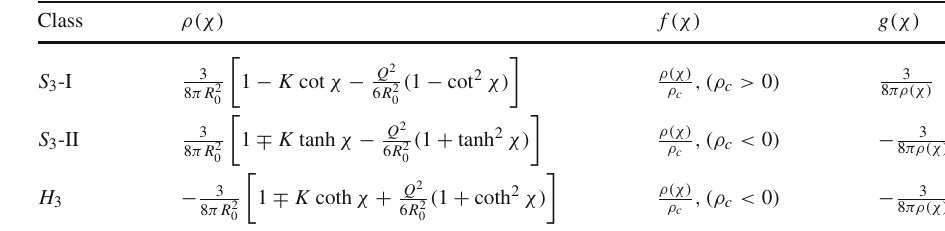
solutions. The signature of ρ c is chosen so that f (χ) g (χ) >